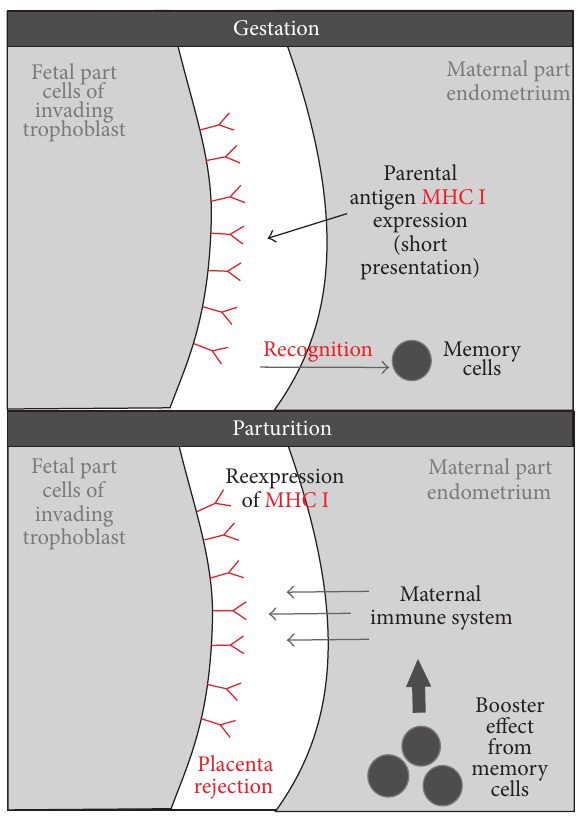
Figure 4: Hypothetical mechanism explaining why expression of classical MHC I during gestation is needed for fetal membranes rejection during parturition. In cows and horses trophoblast has no access to maternal blood (in contrast to humans). In these species trophoblast expresses classical MHC I with paternal antigens during pregnancy. This expression “teaches” maternal memory cells, which recognize paternal (foreign) antigen. If during parturition fetal membranes reexpress classical MHC I with paternal antigens they will stimulate booster effect from maternal memory cells and lead to fetal membranes